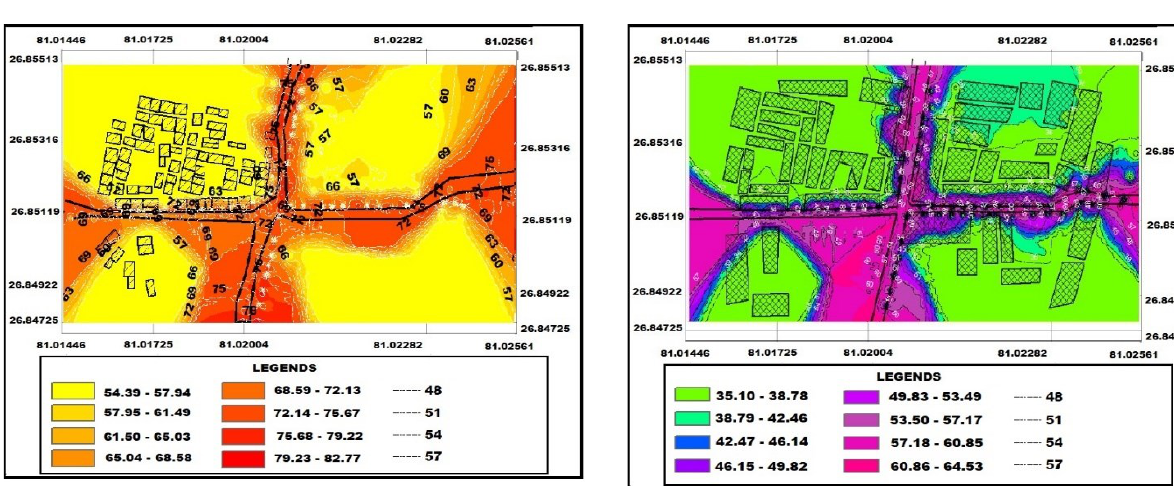
Figure 4. Noise level map of Haniman crossing for unorganized road for afternoon time.